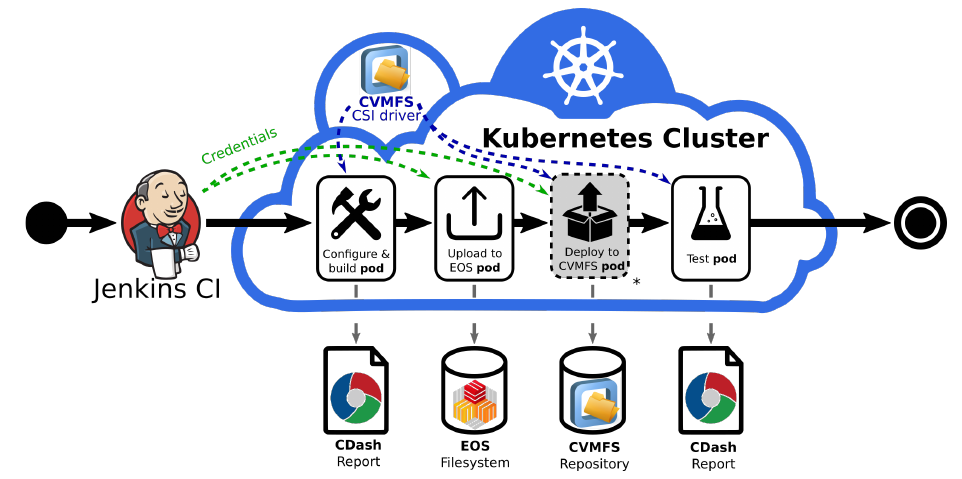
Figure 3. Interactions of the Kubernetes solution with di ff erent system components. The Configure step is at the time of writing not complex enough to warrant a separate pod, but this may change in the